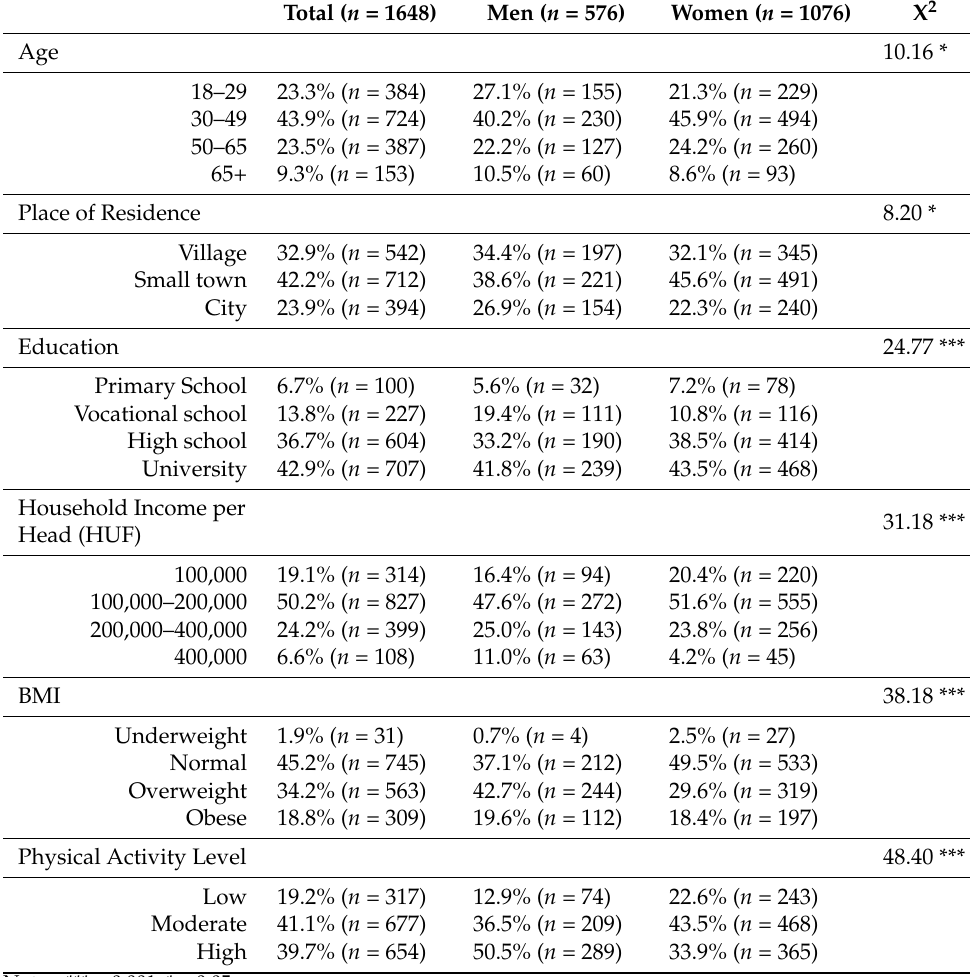
Table 1. Sociodemographics, BMI, and physical activity of the